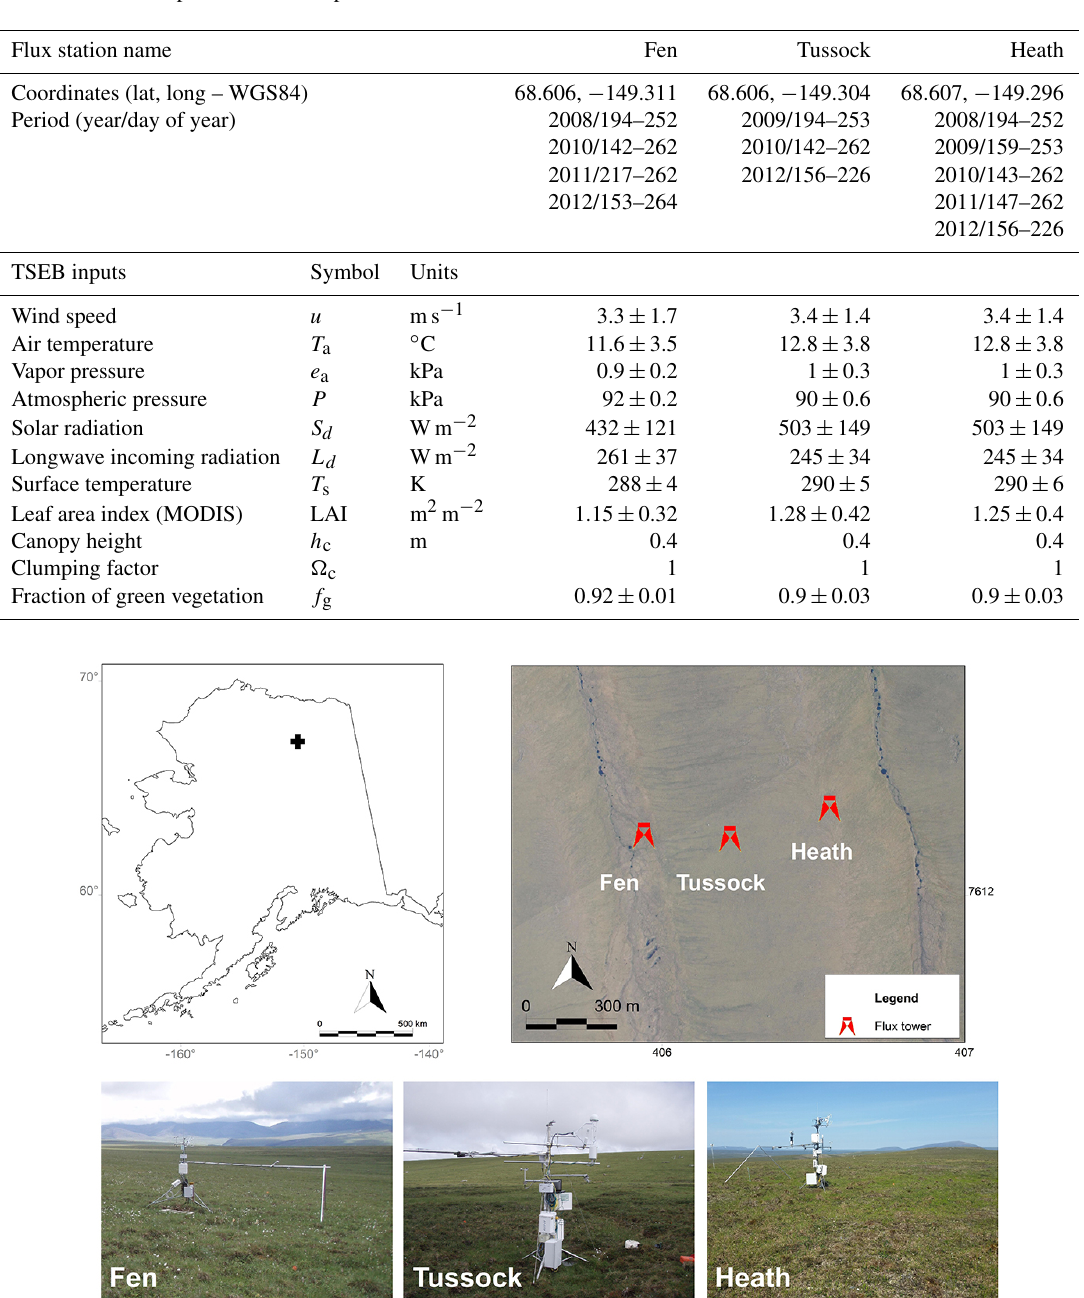
Table 1. Flux station name and location, period of model evaluation and list of inputs required by the TSEB. Average and standard deviation for the input values were computed for the full period of model evaluation for each site.